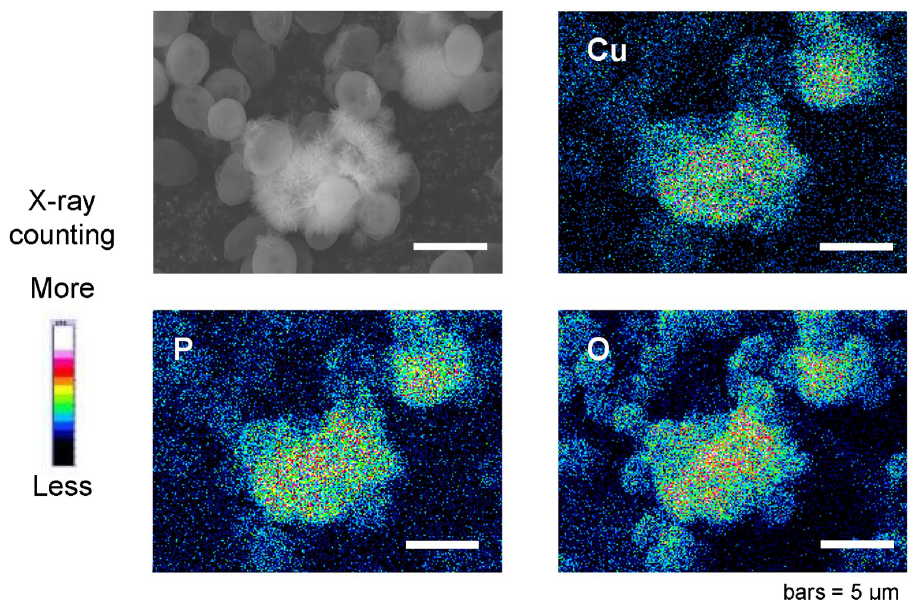
Fig 2. SEM image and two-dimensional localization of copper, phosphorus, and oxygen on phosphorylated yeast cells analyzed by FESEM-EDS. Yeast cell samples were collected on Day 6 of Cu 2+ adsorption.